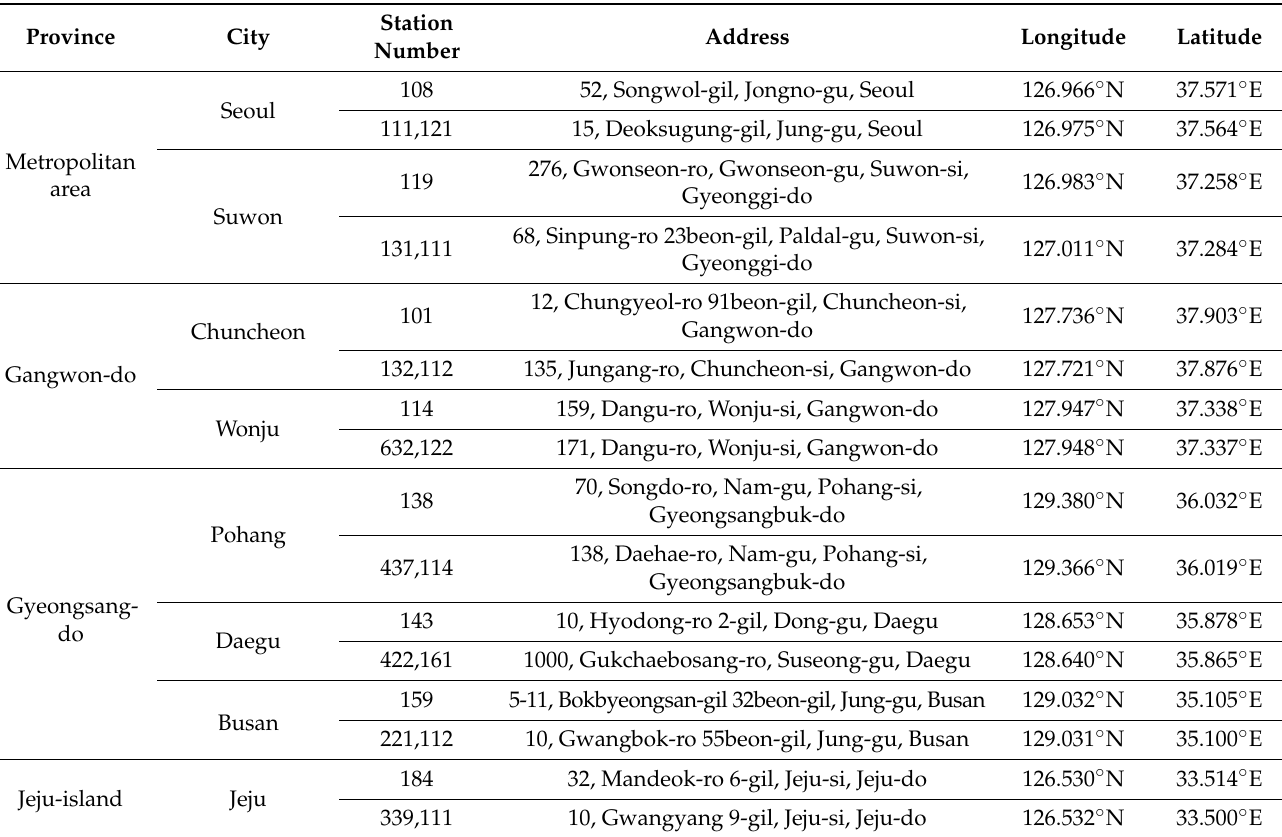
Table A1. Location of ground meteorological observatory (top) and PM observatory